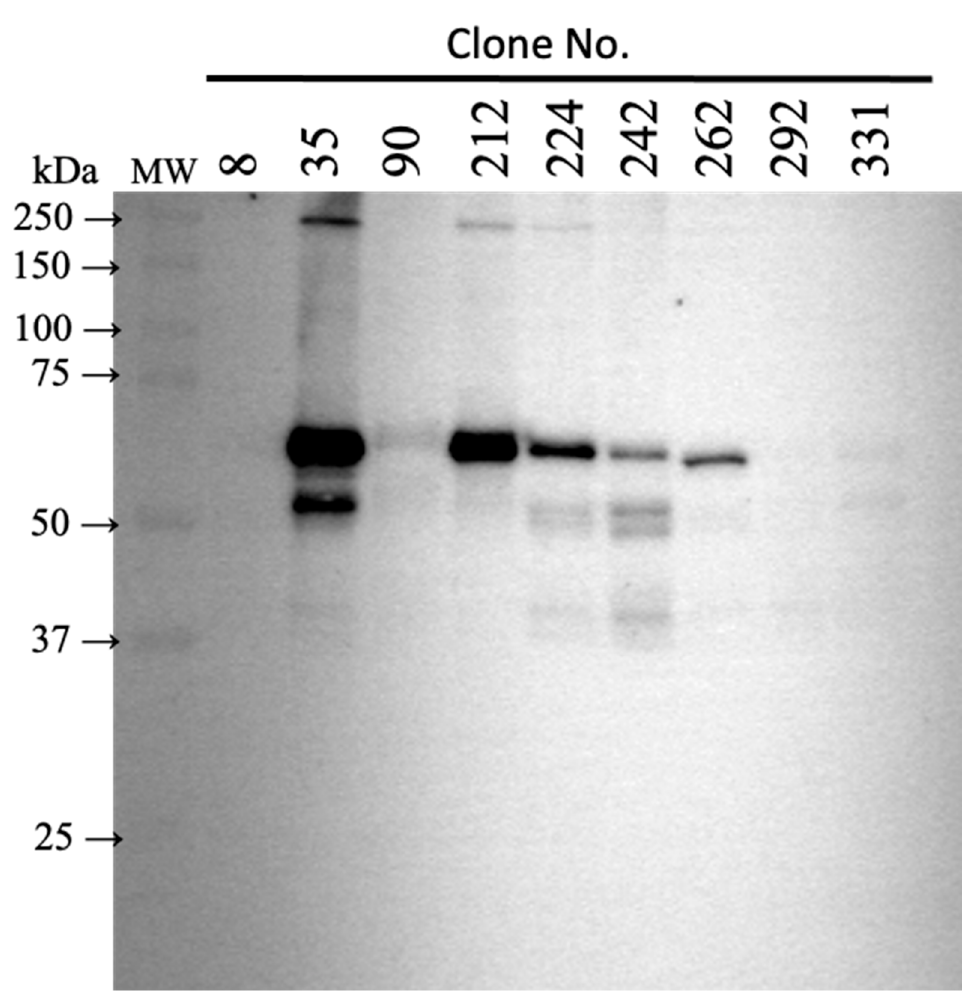
Figure 3. Expression of humanized IgG clones. The conditioned media were analyzed by Western blotting with anti-human IgG-Fc antibody. The conditioned medium of non-transformed ExpiCHO-S cells was used as a negative control.